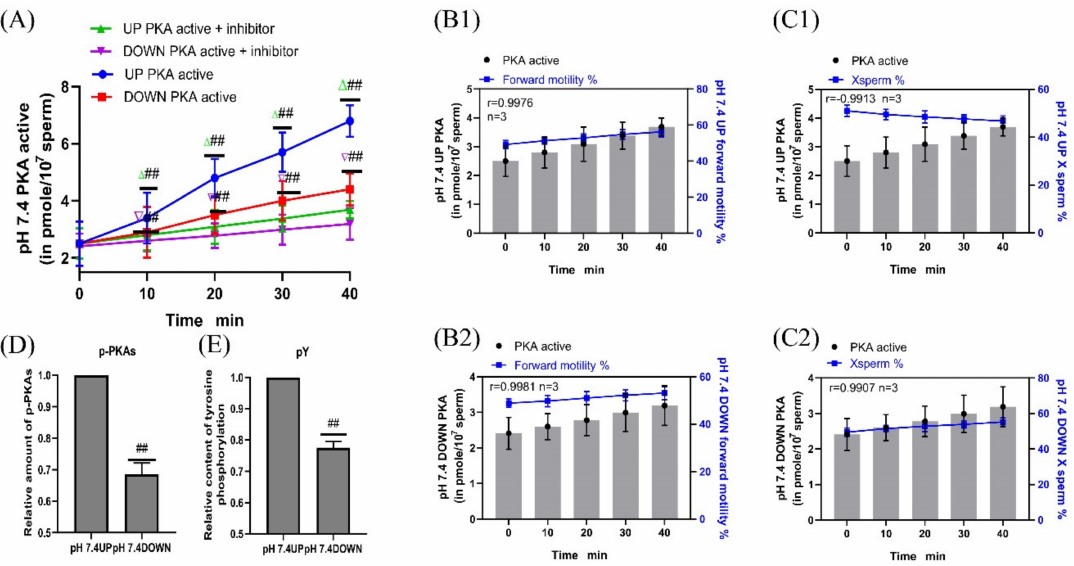
Figure 8. Sperm motility following inhibition of PKA protease activity. ( A ) Changes in PKA protease activity in sperm after H89 supplementation. ( B1 , B2 ) PKA protease activity was correlated with the proportion of forwardly motile spermatozoa. ( C1 , C2 ) Correlation between PKA protease activity and the proportion of X-chromosome-bearing sperm. ( D , E ) Statistics of p-PKAs and pY content in sperm after the addition of PKA kinase activity inhibitors. Results are expressed as mean ± SEM, n = 3 experiments. Two-way ANOVA and Bonferroni’s multiple comparison test. (##) indicates significant differences between the two groups ( p < 0.01).